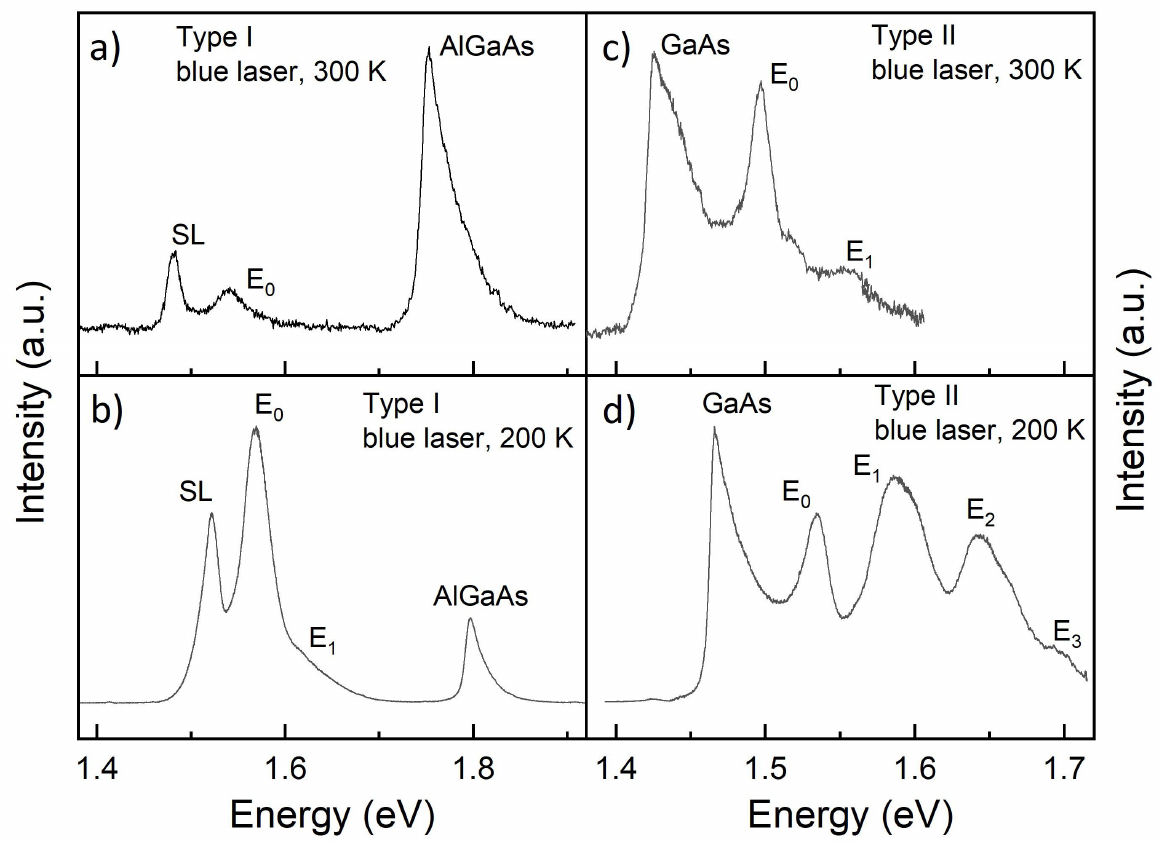
Figure 7. PL data from type I and type II samples taken with a blue laser (405 nm). ( a ) Type I, T = 300K, ( b ) type I, T = 200K, ( c ) type II, T = 300K, ( d ) type II, T = 200K. The labels, GaAs and AlGaAs, denote the substrate and barrier bulk-peaks, SL the AlAs/GaAs superlattice, and E 0 , E 1 , ... the QD